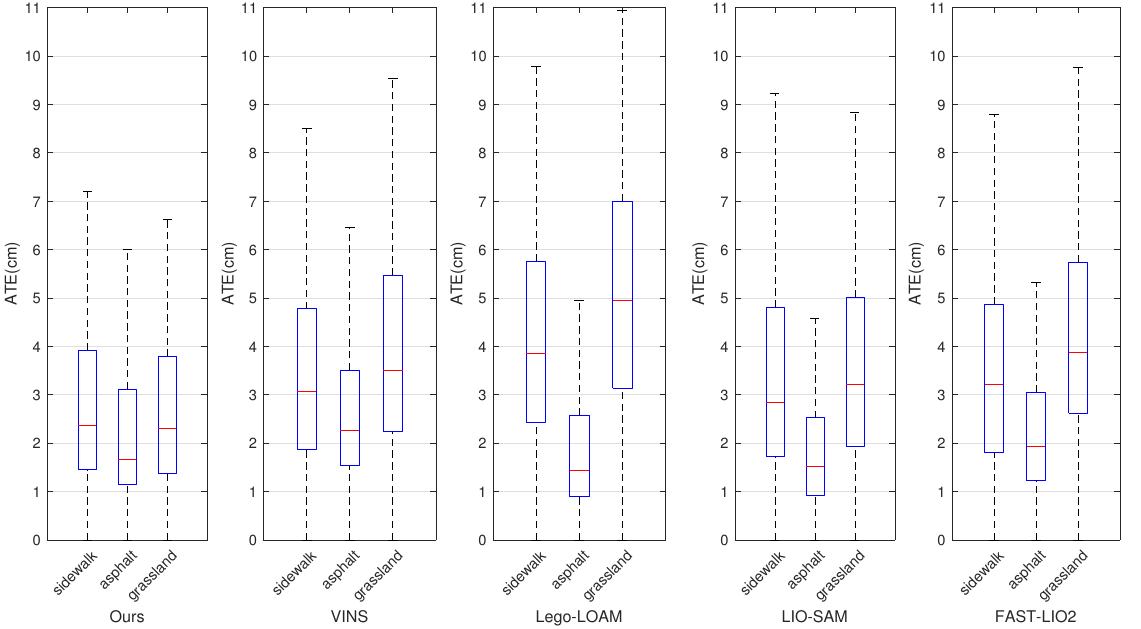
Figure 7. Absolute trajectory errors of the trajectories estimated by different LIO systems compared with GPS ground truth in different ground